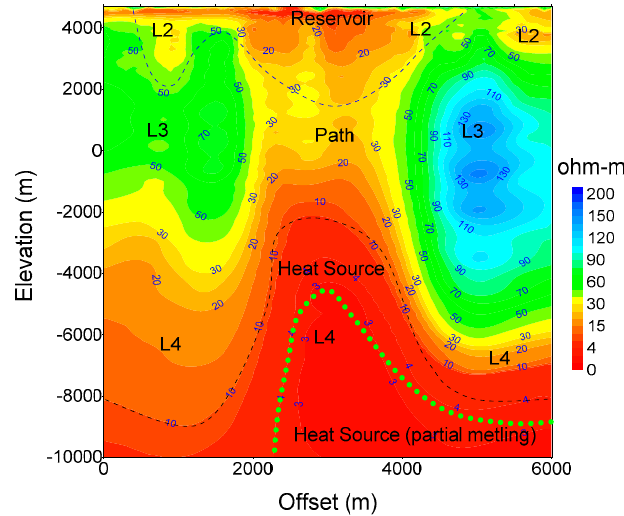
Figure 4. Conversion results from a MT section (Line2 as shown in Figures 2 and 5) illustrate the typical geo ‐ electric structure of the QP geothermal field. L2 to L4 show the geo ‐ electric layer, L2 is a low ‐ resistivity layer mainly reflecting the reservoir (marked with the blue dashed line) which contains the brine thermal fluids (water); L3 is a resistive layer that reflects the host rock and path (has lower resistivity than the host rocks); L4 is a low resistivity layer, which the major portion reflects the heat source (marked with the black dashed line). The lower portion of L4 (marked with the green dashed line) is interpreted as partial melting.